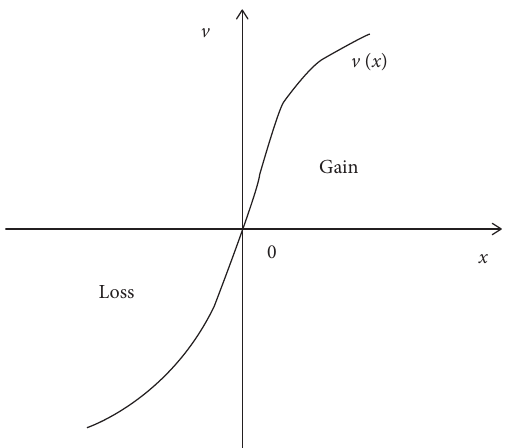
Figure 1: Value function v ( x )